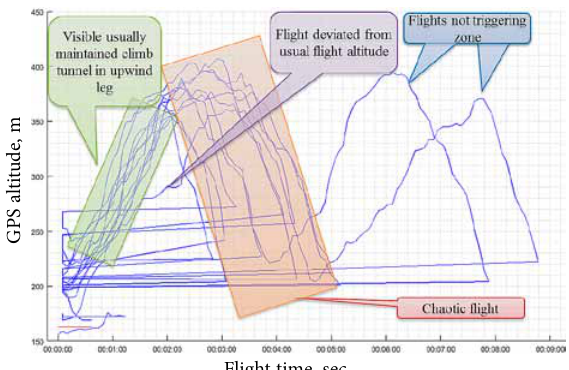
Fig. 17. Trigger zones of the flight